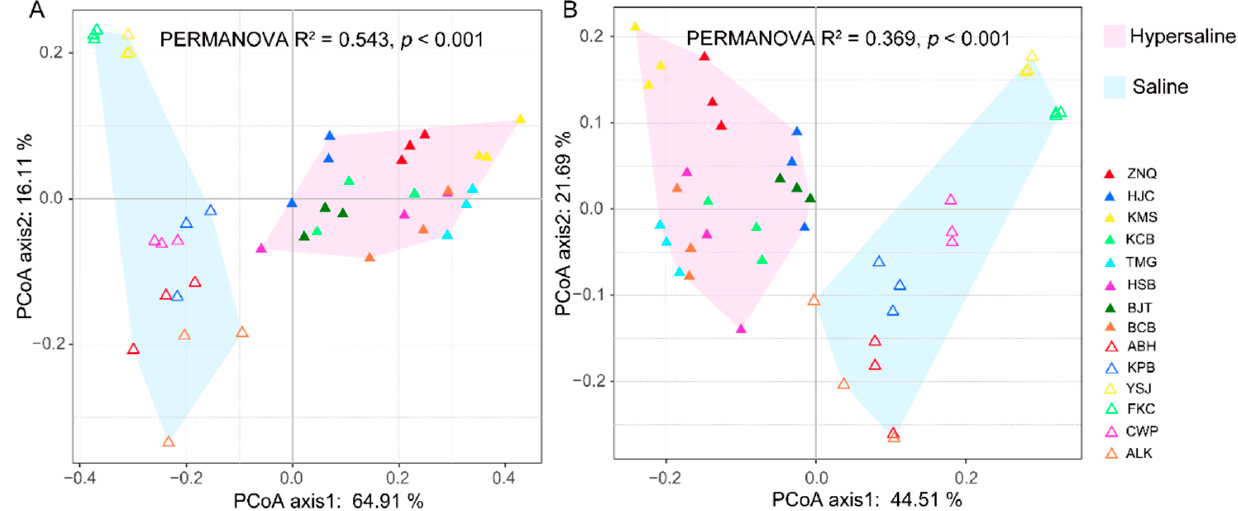
Figure 3. PCoA plot at the phylum ( A ) and genus ( B ) level illustrating the separation of microbial communities along axis 1 corresponding to the saline and hypersaline soils.